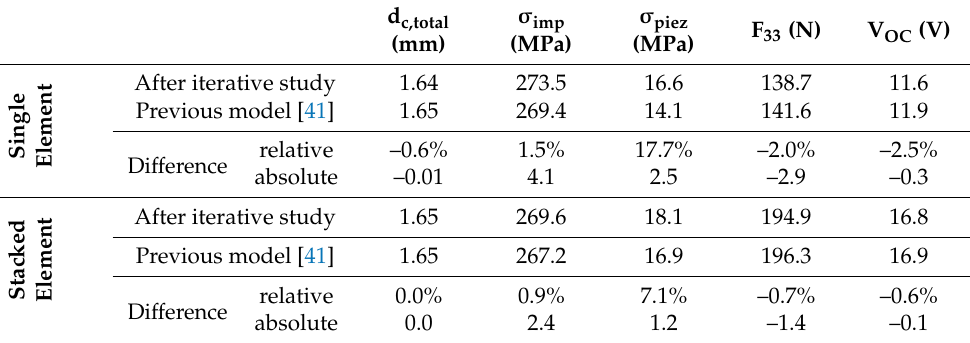
Table 5. Results of the iterative study to reproduce the implant and piezoelectric element loading situation from previous work [41] for single and stacked configurations. Final output values of the new loading situation with absolute and relative differences from the previous